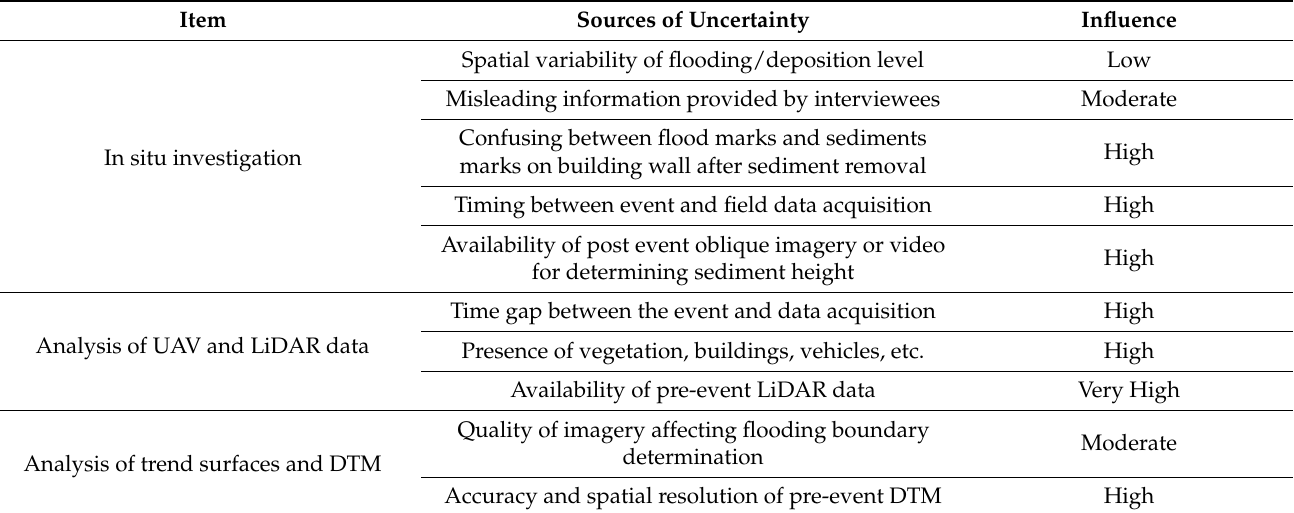
Table 5. Sources of uncertainty and their degree of influence on